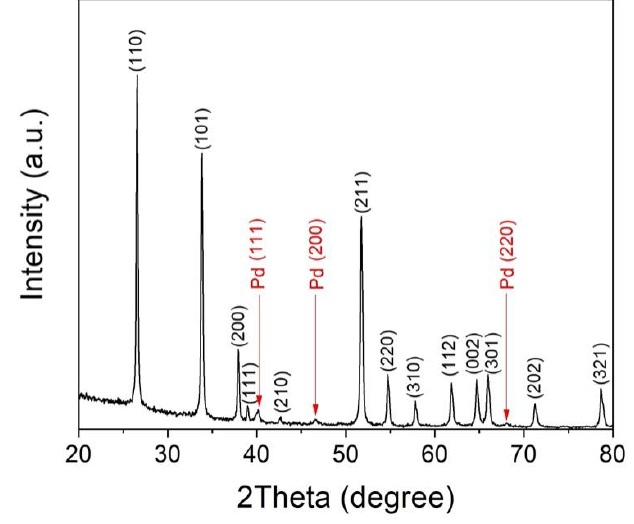
Figure 2. X-ray diffraction pattern taken for the surface of a pellet of 5 wt% Pd after being sintered at 950 °C for 2 h in air.